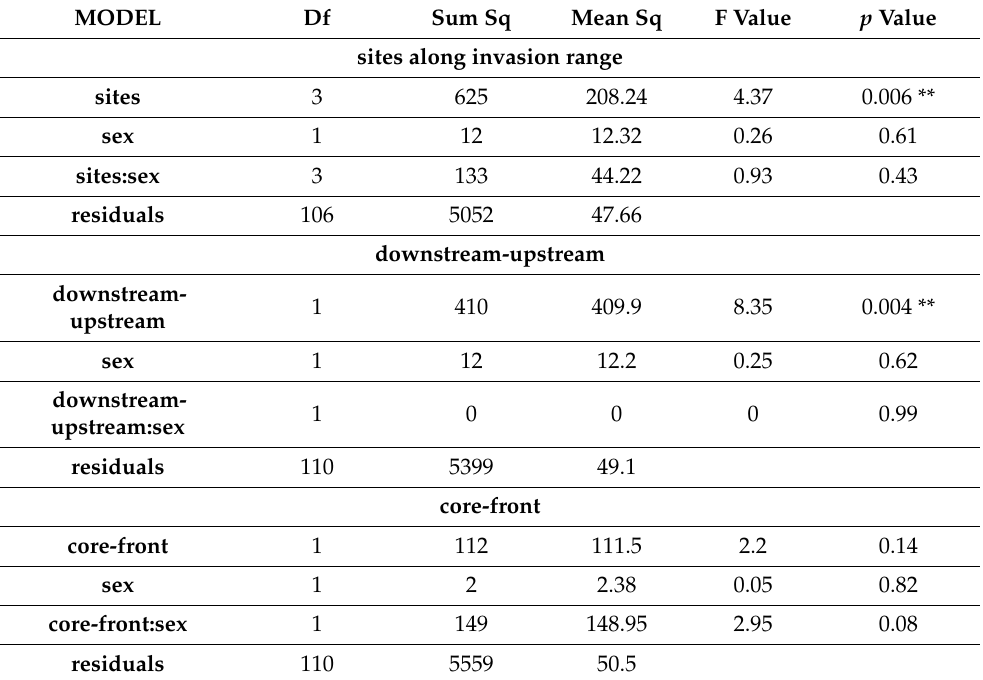
Table 2. Generalized linear model (GLM) fitted with aov on PLS-R scores of immune parameters of signal crayfish. Significant differences ( p < 0.01) are indicated with **. Df = degrees of freedom, Sum Sq = sum of squares, Mean Sq = mean